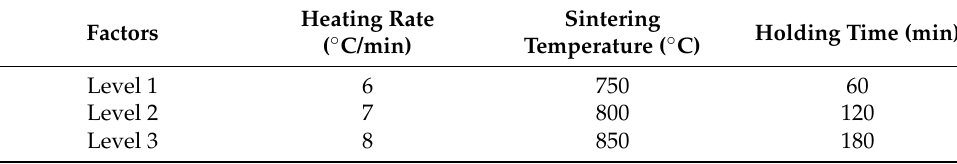
Table 2. Orthogonal factors and standard selection